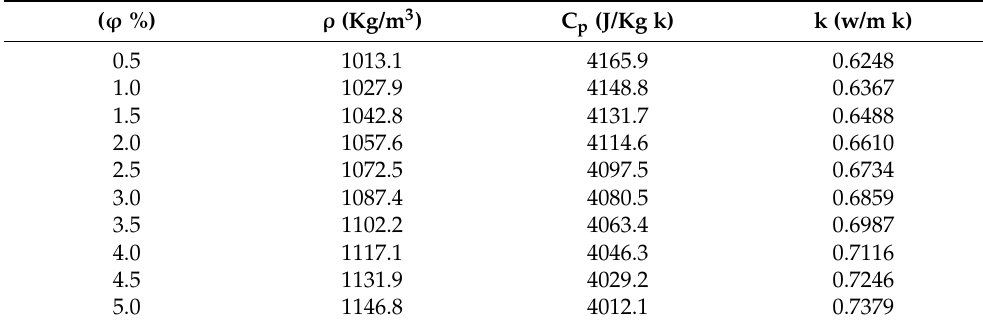
Table 3. Thermal parameters of Al 2 O 3 Nano-non-Newtonian, reproduced with permission from